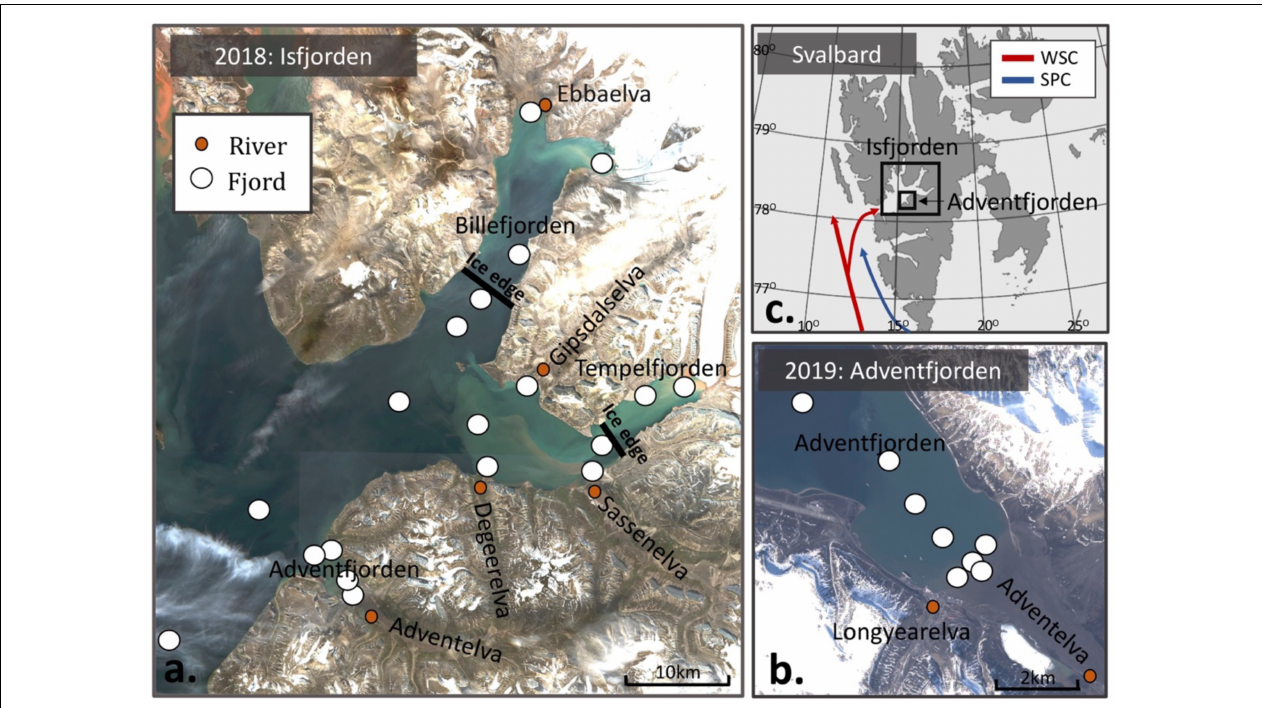
FIGURE 1 | (a) Station map of Isfjorden (sampled in 2018), and (b) Adventfjorden (sampled in 2019), superimposed on satellite images taken from the same week as sampling [August 20, 2018 and June 14th, 2019; Sentinel-2 (https://scihub.copernicus.eu/)]. The location of the ice edge in May 2018, when land-fast ice covered the inner fjord arms, is indicated in black. (c) Map of Svalbard with the West Spitsbergen Current (WSC) and Spitsbergen Polar Current (SPC) depicted in red and blue respectively.